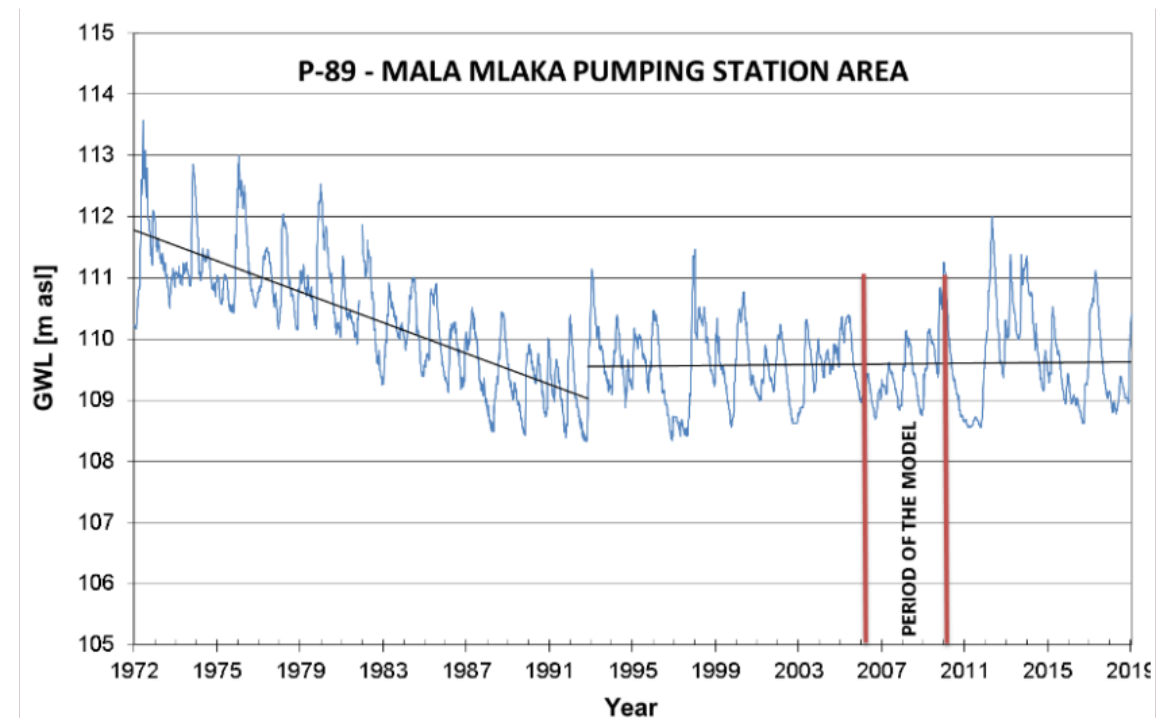
Figure 5. Groundwater levels in the Mala Mlaka pumping station area (piezometer P-89).